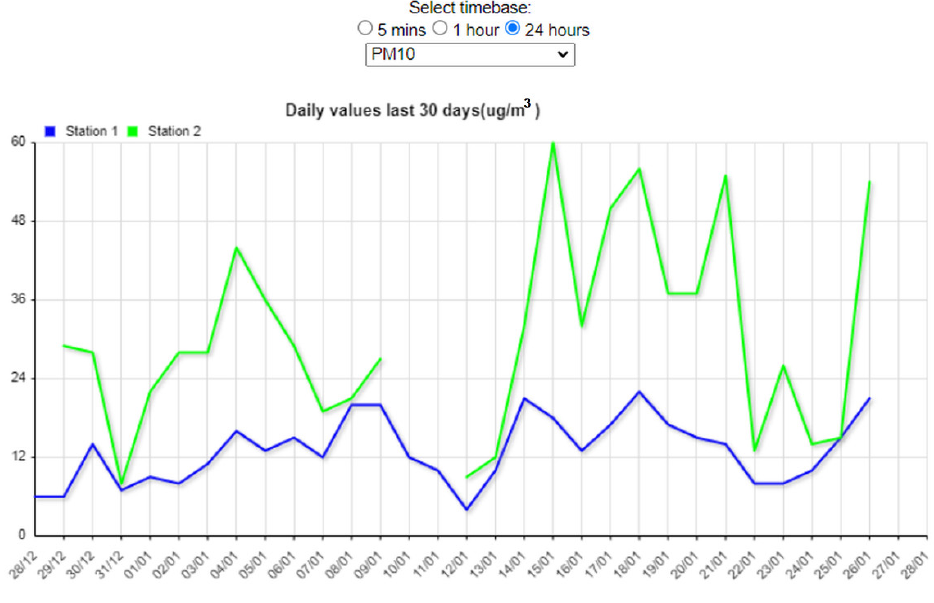
Figure 4. Group diagram for selected time-period.